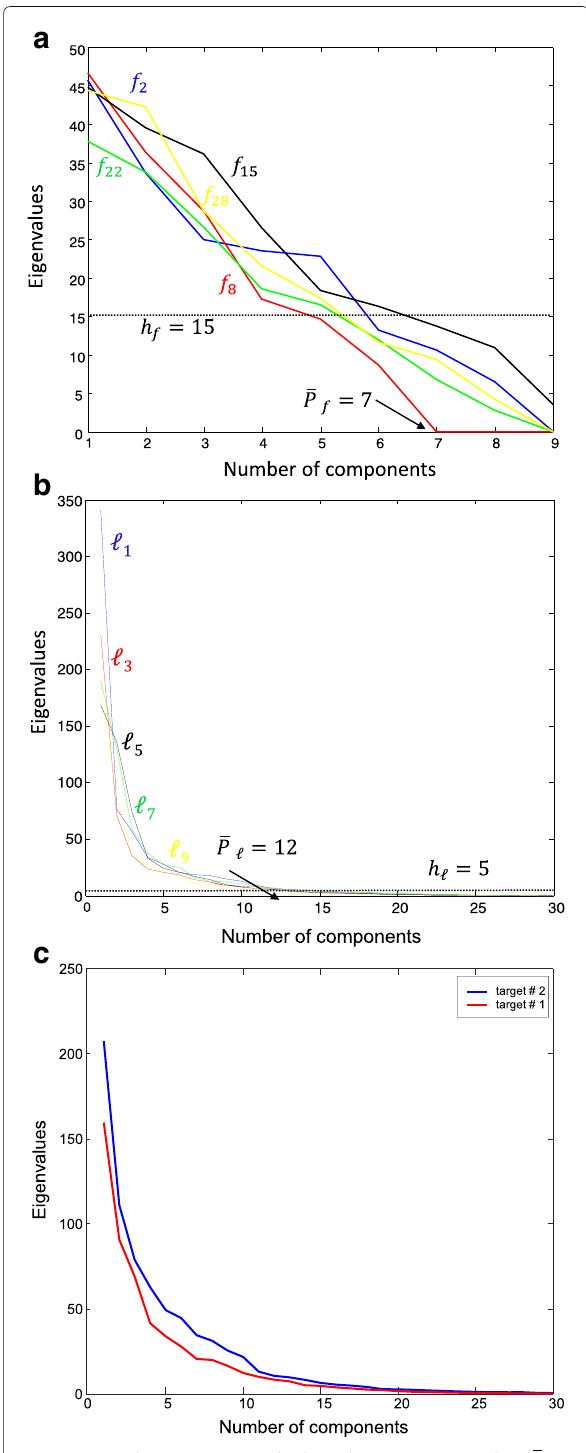
Fig. 6 Principal components and selected component numbers P (cid:2) and P f obtained during the training phase from single target measurements with a space-domain and b frequency-domain CSI measurements. In c , the components corresponding to the two different targets #1 and #2 for the given link (cid:2) 1 are